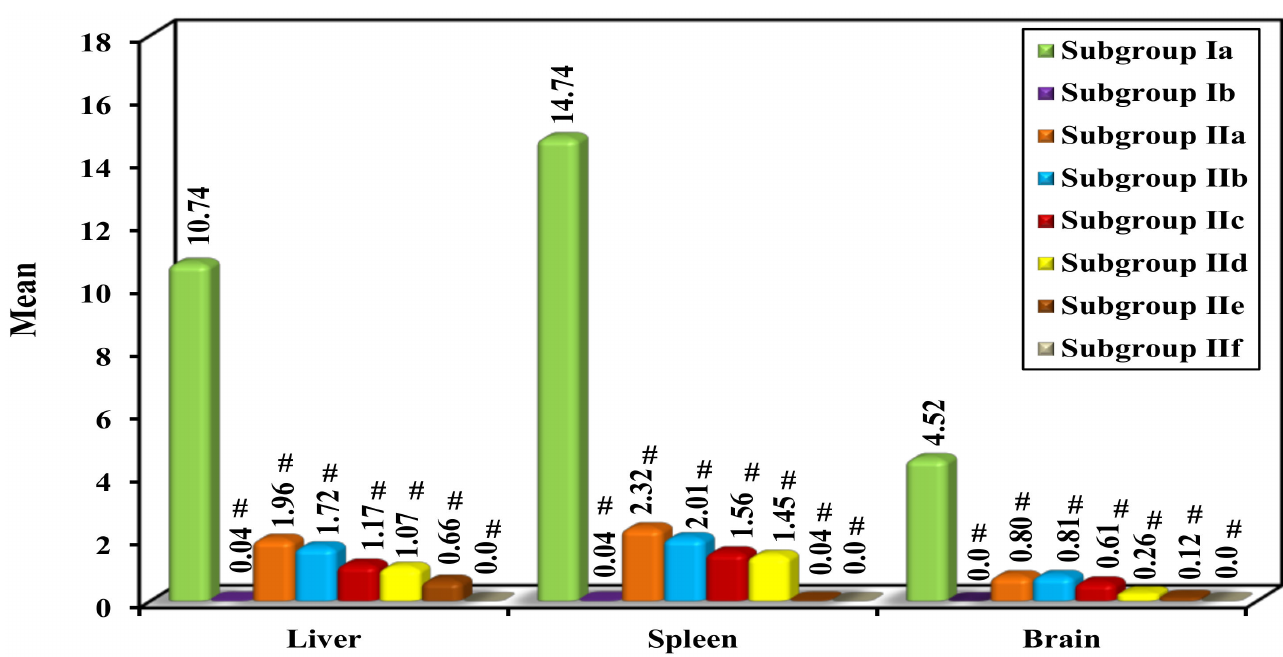
Figure 6. Mean tachyzoites count in the liver, spleen and brain of the different studied subgroups. #: Significant with subgroup Ia